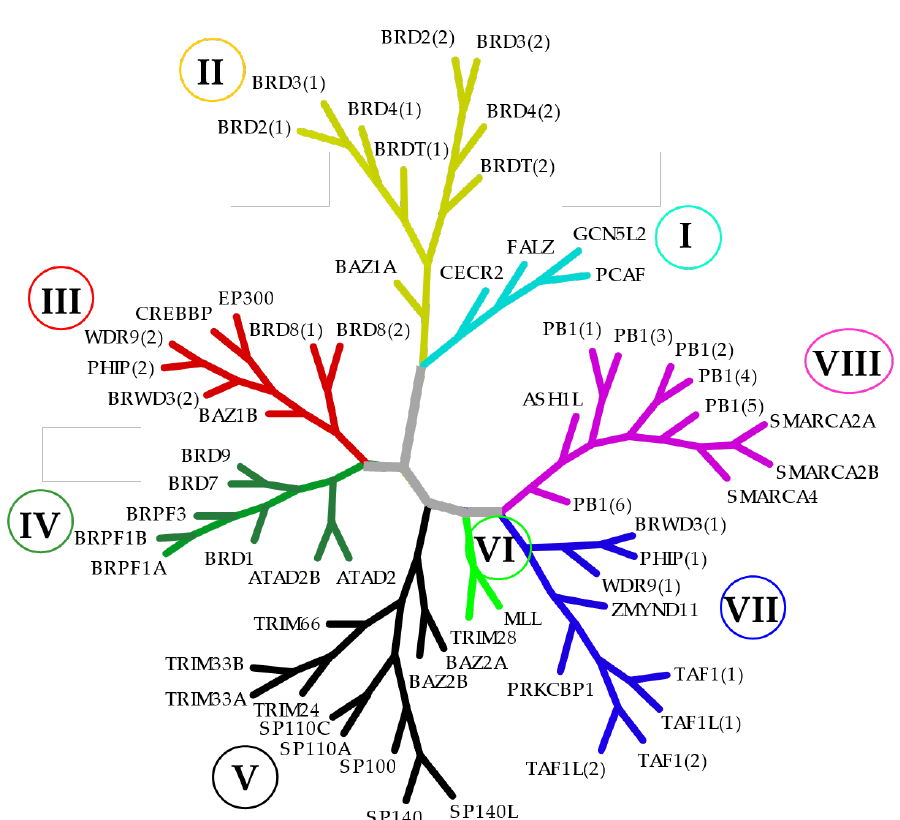
Figure 4. Phylogenetic tree of the human bromodomain-containing protein subgroups. On the basis of sequence homology, BCPs are classified into eight different subgroups (families). The distinct families are indicated by Roman numbers (I–VIII) in circles and illustrated with different colors.